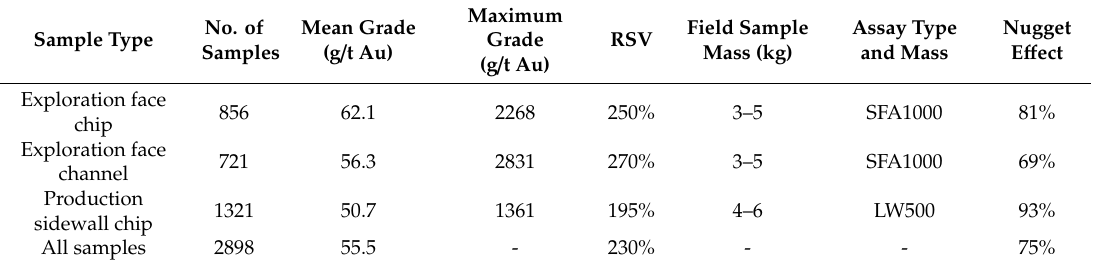
Table 30. Statistics of di ff erent sample types within the Nalunaq database (as of 2006).